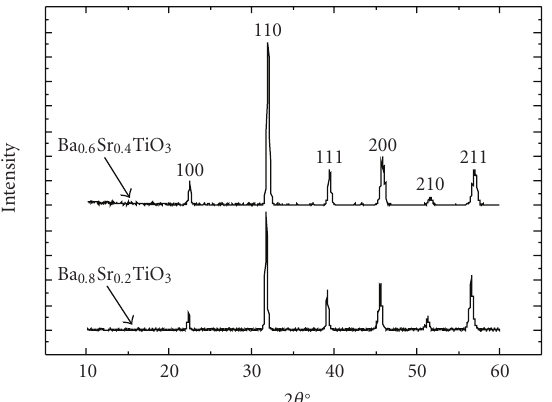
Figure 1: X-ray di ff raction pattern of BST(0.2) and BST(0.4) ceramics